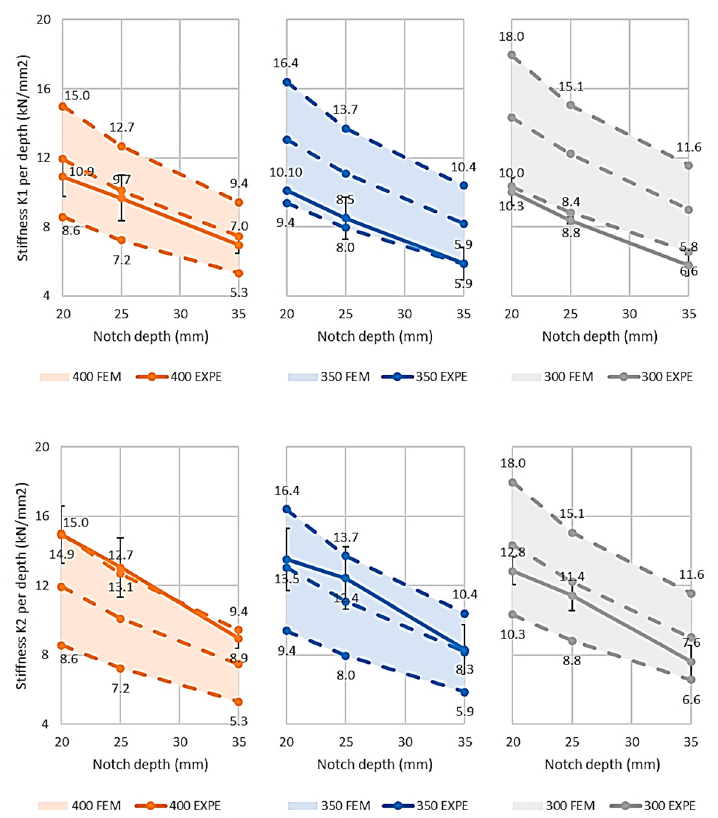
Figure 16. FEM envelop of stiffness K1 and K2 per depth of multiple heel length.